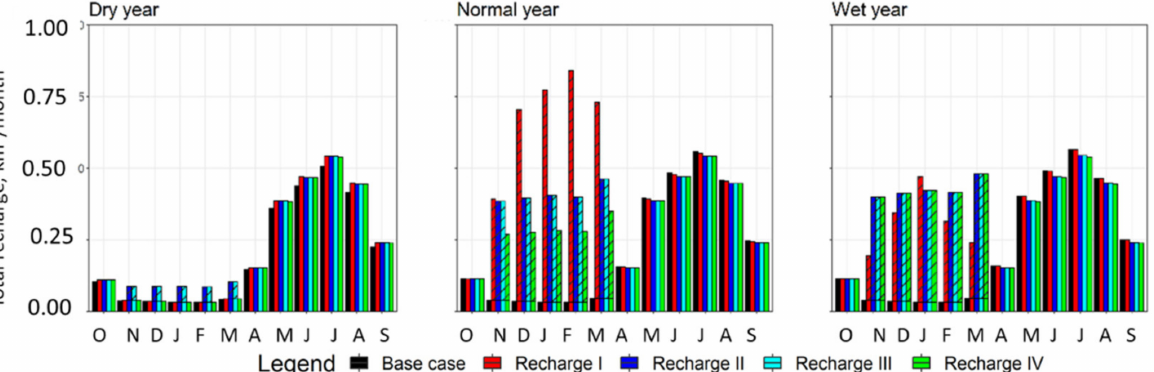
Figure 5. Monthly total recharge to the groundwater basin in different dry, normal, and wet scenarios. Hatched portion represents the additional recharge flow from the recharge facility,